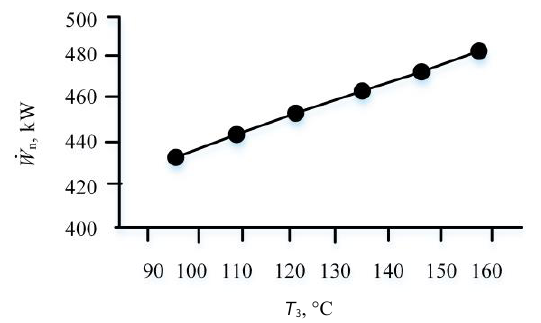
Fig. 3. Variation of net power output with temperature.